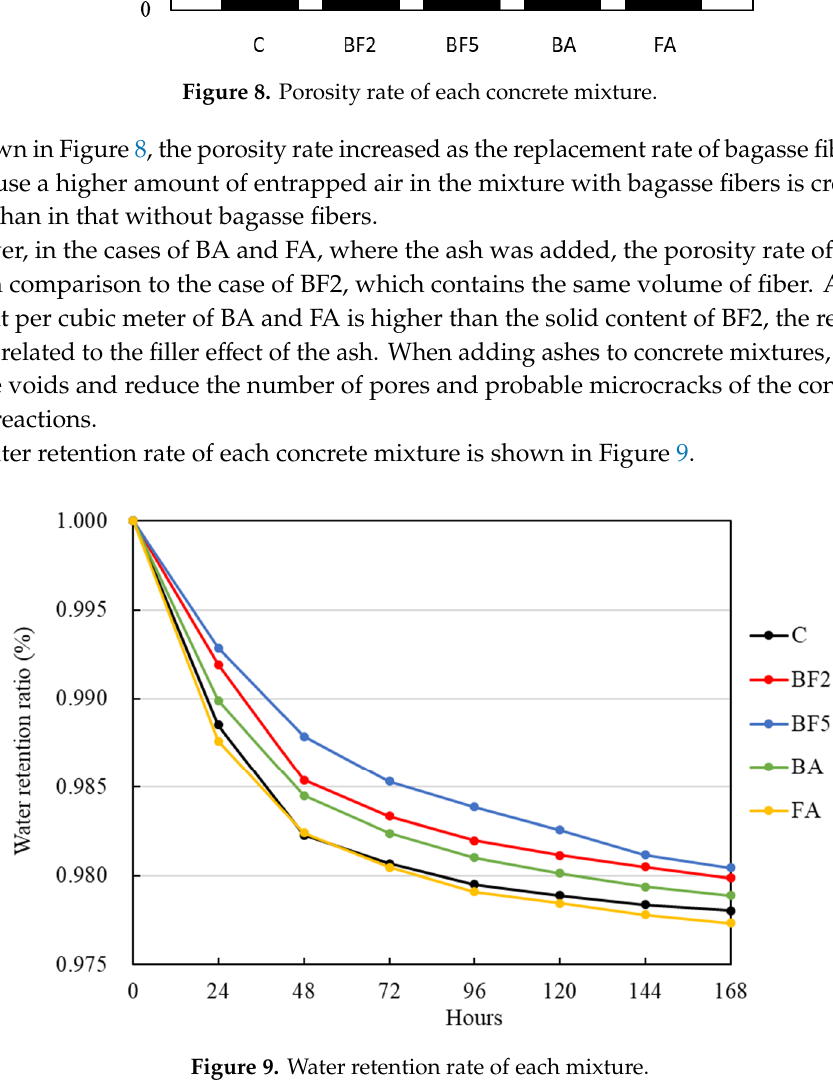
Figure 9. Water retention rate of each mixture.